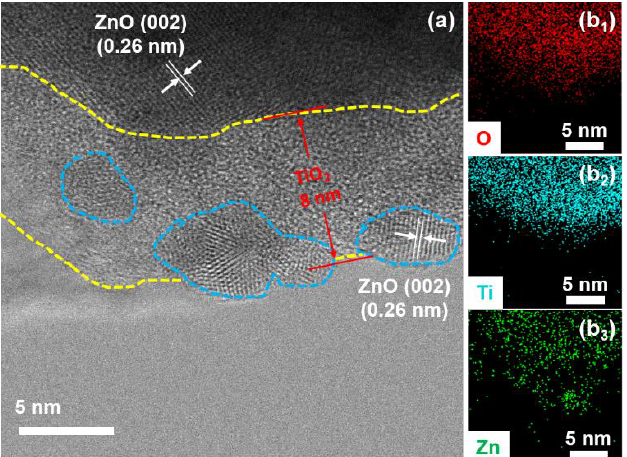
Figure 5. ( a ) STEM image focus on TiO 2 coating layer, and its corresponding EDS mappings of ( b 1 ) O, ( b 2 ) Ti, and ( b 3 ) Zn.